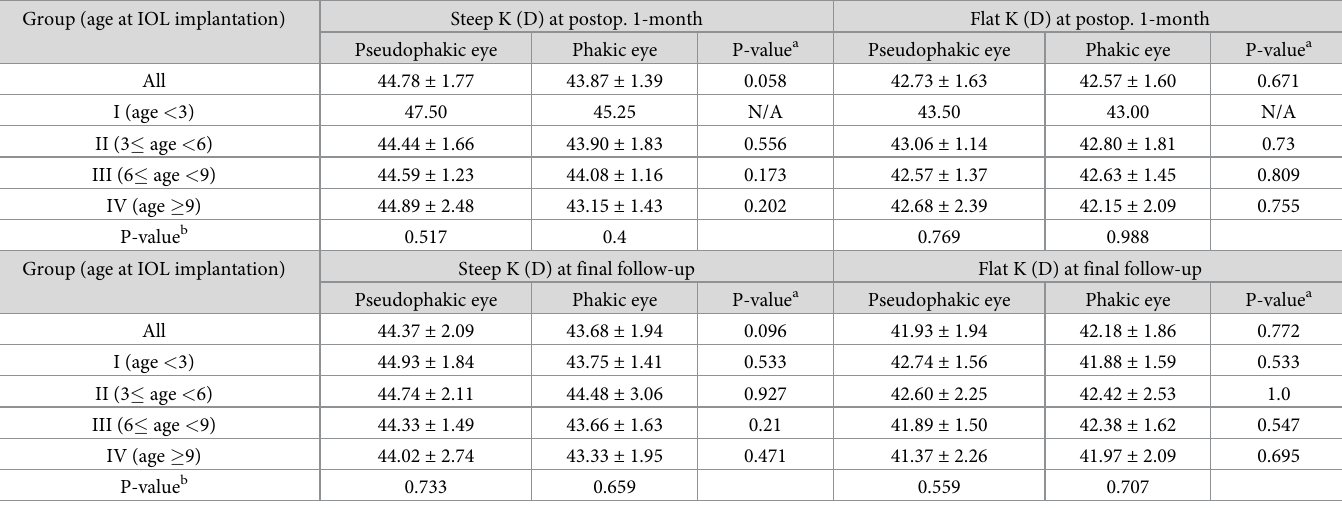
Table 4. Keratometry values of pseudophakic and fellow phakic eyes at postoperative one-month and at final follow-up after unilateral pediatric cataract surgery. Group (age at IOL implantation) Steep K (D) at postop. 1-month Flat K (D) at postop. 1-month Pseudophakic eye Phakic eye P-value a Pseudophakic eye Phakic